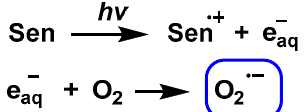
2 O 2 forms HO 2